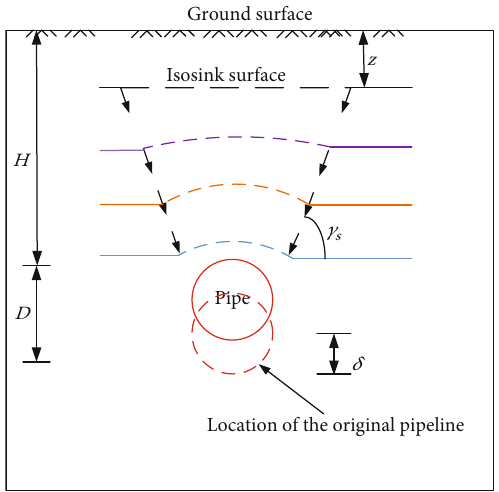
Figure 12: Compression of the soil at the top of pipeline in subsidence